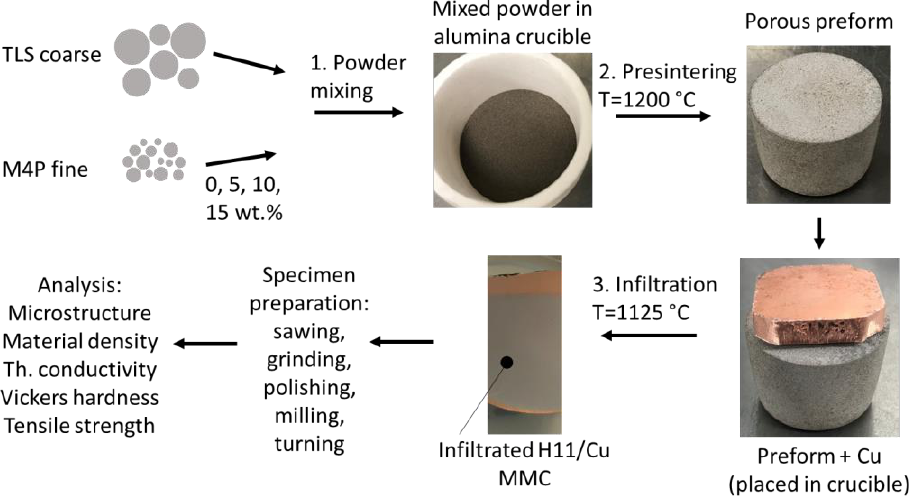
Figure 2. Preparation of H11/Cu MMCs, including the steps of powder mixing, presintering to obtain a porous preform and infiltration of the preform with molten copper.